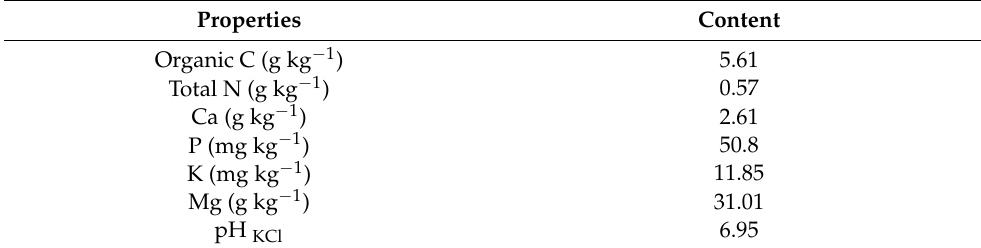
Table 1. Soil properties at the experimental site (0–25 cm).